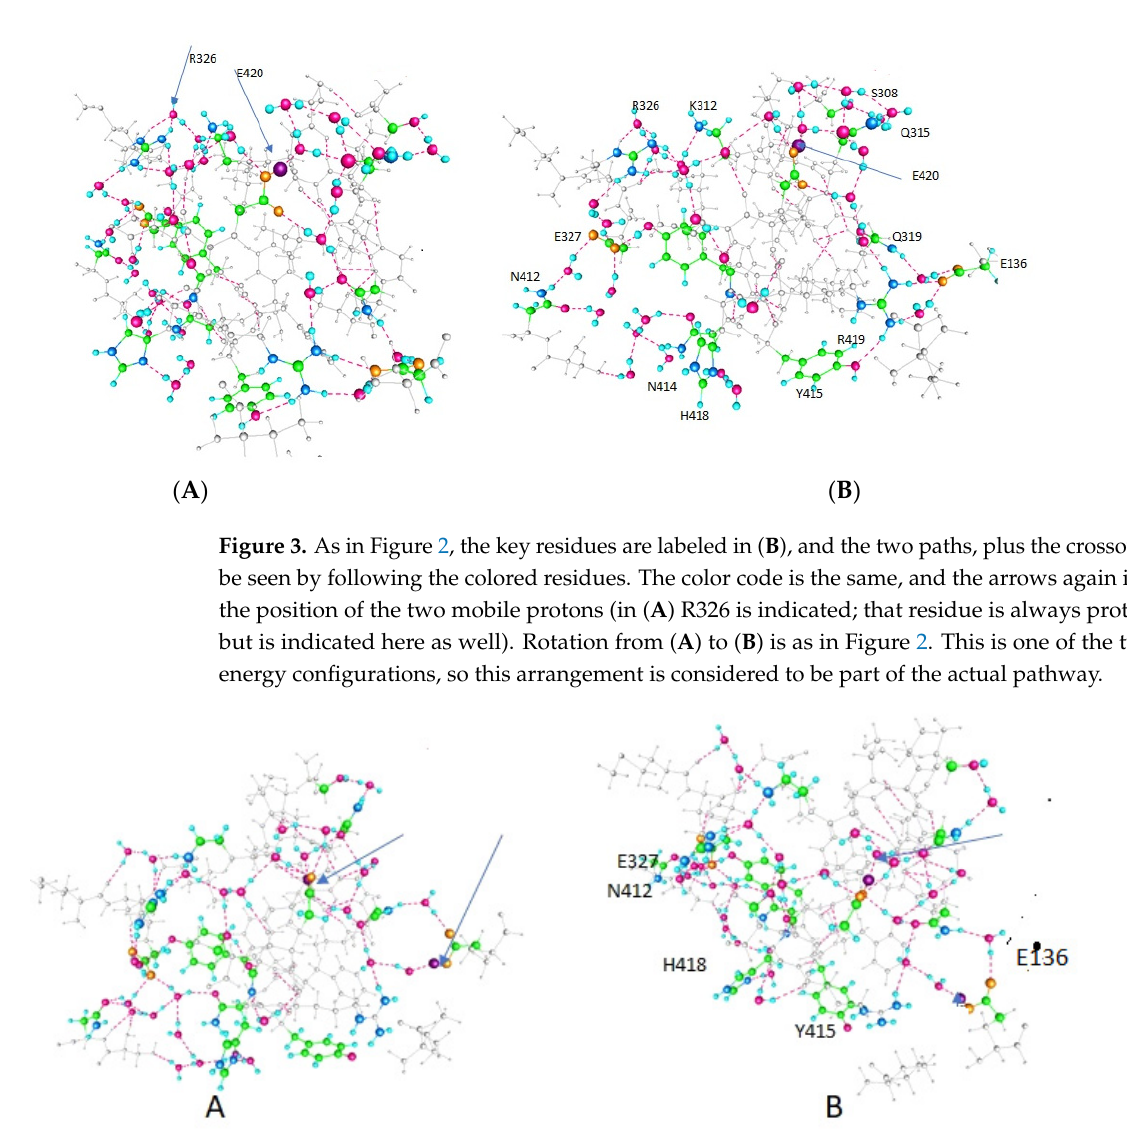
the proton path, are shown in gray. In addition to the upper and lower paths, there is a crossover that apparently allows protons to switch paths; this is the vertical path in the left ‐ center. The gate is on the left, the VSD on the right and above. Color code: Carbon, green; nitrogen, large blue sphere; hydrogen, small pale blue spheres; oxygen, magenta. The added protons are not visible, but their positions are indicated by the arrows.